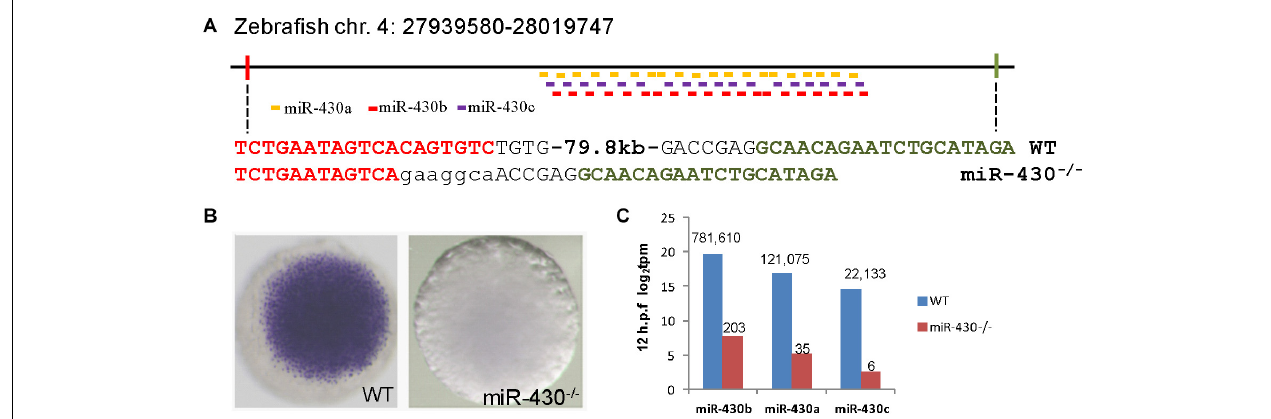
FIGURE 1 | Targeted deletion of miR-430 in zebrafish. (A) Genetic deletion of zebrafish miR-430 cluster using TALENs. A 79.8 kb genomic fragment containing the zebrafish miR-430 was deleted using two pairs of TALENs. The TALEN binding sites were shown in colors and the inserted nucleotides were shown in lower case letters. MiR-430 isoforms were indicated by colored short lines. (B) In situ hybridization detection of pri-mir-430 expression in the WT and miR-430 − / − mutant embryos at 4 hpf. (C) Expression profiles of mature miR-430 isoforms in the WT and miR-430 − / − mutant embryos (12 hpf) by small RNA deep sequencing. The numbers of normalized reads were indicated. TPM, transcripts per kilobase million.